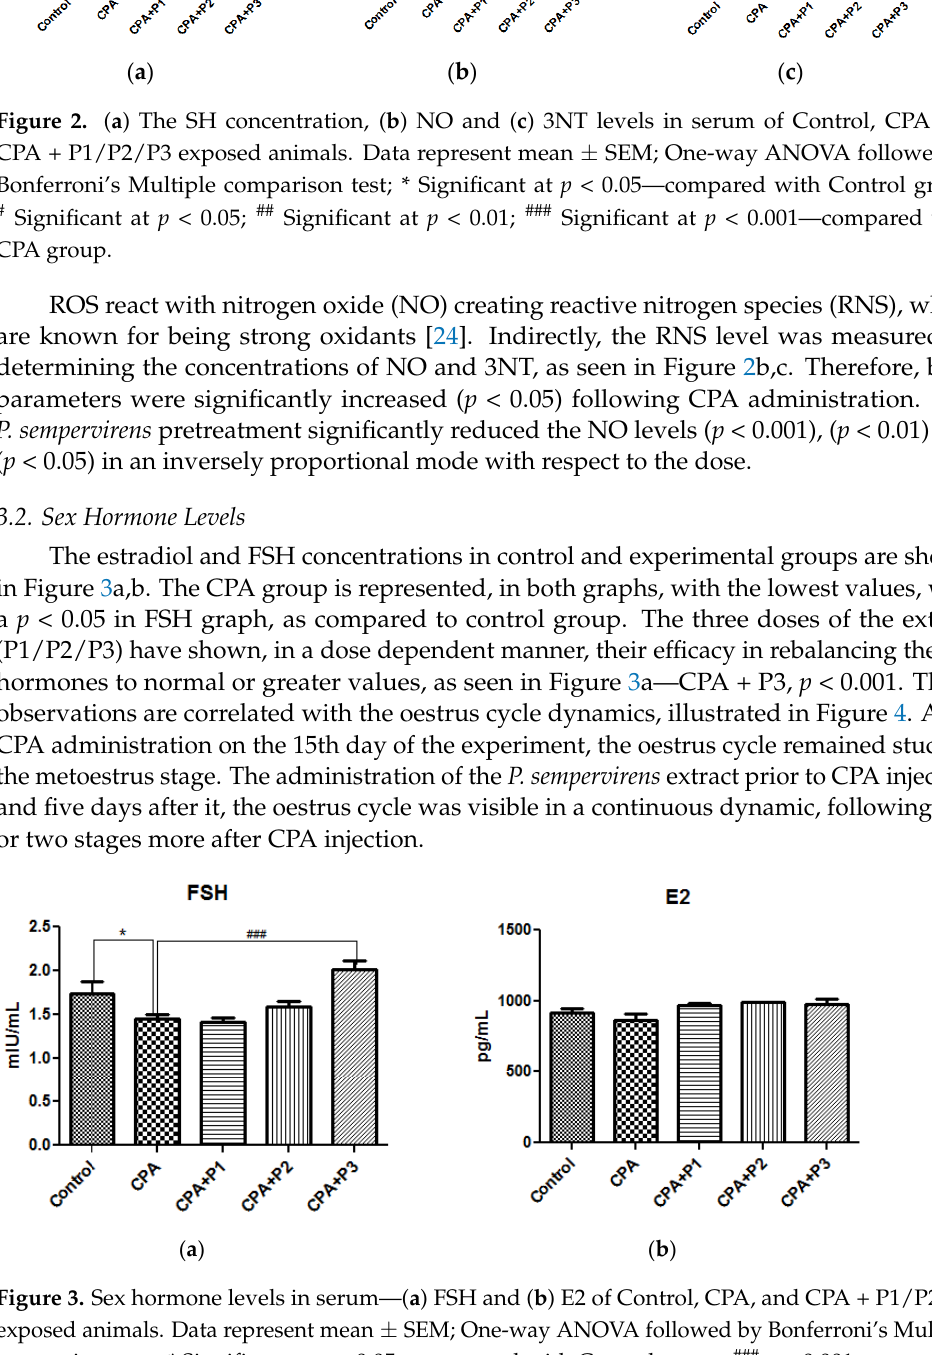
Figure 4. The oestrus stages determined by vaginal cytology (pro-oestrus (P), oestrus (E), metoestrus (M) and dioestrus (D)) in Control, CPA, and CPA + P1/P2/P3 groups. The oestrus cycle respects a repetitive dynamics at almost every five days, except the CPA group which blocking in the metoes- trus stages is evident after CPA administration. 3.3. Ultrastructure of the Ovarian Cell The ultra-thin sections investigated by TEM support the previous biochemical obser- vations, by which the CPA administration to experimental animals induced significant injuries. As seen in Figure 5B, the ovary exposed to CPA was poorly populated with li- pidic granules, which are prominent in control animals (Figure 5A). The untreated sam- ples showed several layers of theca cells, which are elongated and smaller as compared with the granulosa cells. The latter ones are arranged concentrically, most of them with a round nucleus and possessing many electron dense granules, that most likely represent hormone secretions. Interestingly, the extract pretreatment could prevent the hormone deprivation, as seen in Figure 5C – E with a focus on the P2 and P3 doses, that could clearly increase the number and the electron-density of the granules (P2) or only the number of the granules (P3). Besides, the structure of the granulosa cells appeared to be very well preserved after P2 and P3 doses. As the dose of the extract increases (Figure 5E) the per- fectly round-shaped nuclei are more prominent.